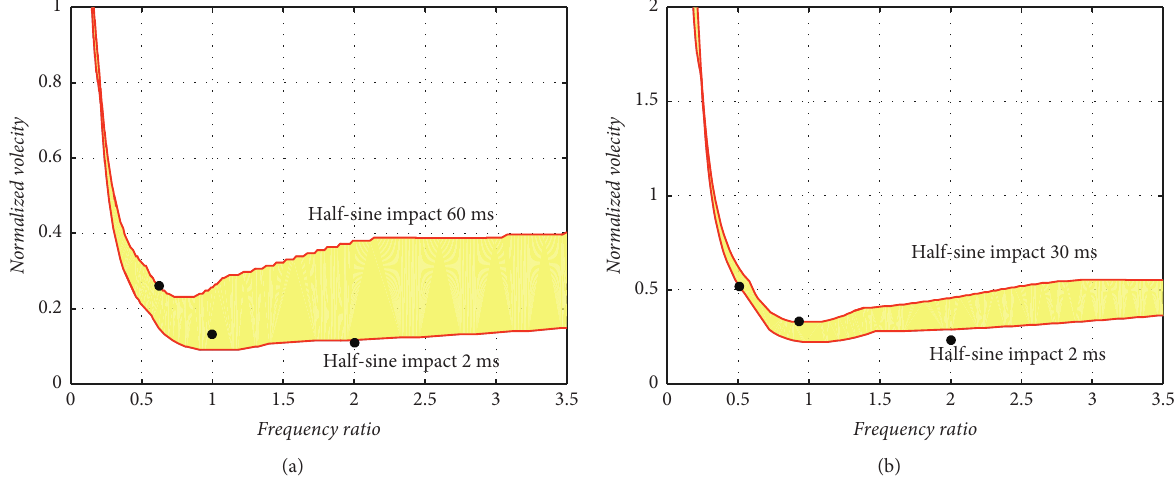
Figure 11: DDBCs of a packaging system with tangent stiffness under half-sine pulses for different durations. (a) 2 g . (b) 5 g .